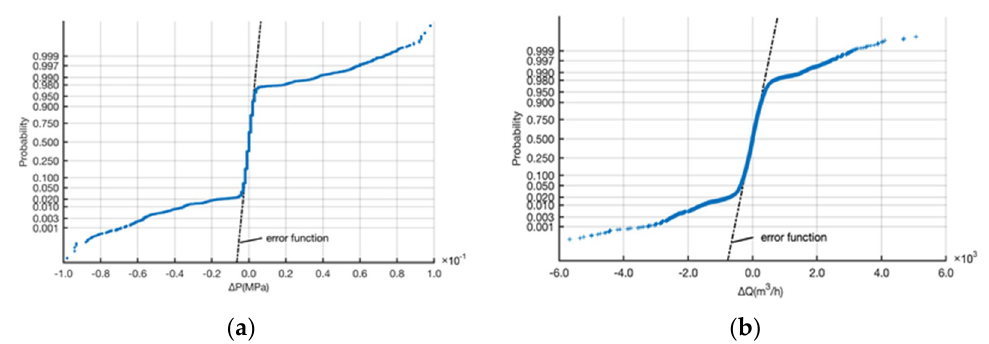
Figure 6. Cumulative probability curves of ( a ) pressure and ( b ) flow fluctuations at the pumping station.